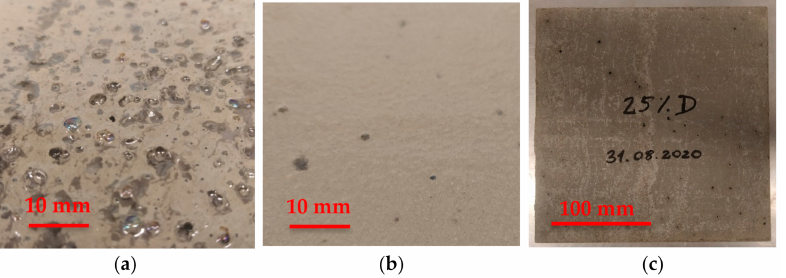
Figure 1. Mortar emitting gaseous ammonia, ( a ) after compaction, ( b ) a few seconds after floating the surface, ( c ) hardened mortar with visible holes (black dots).